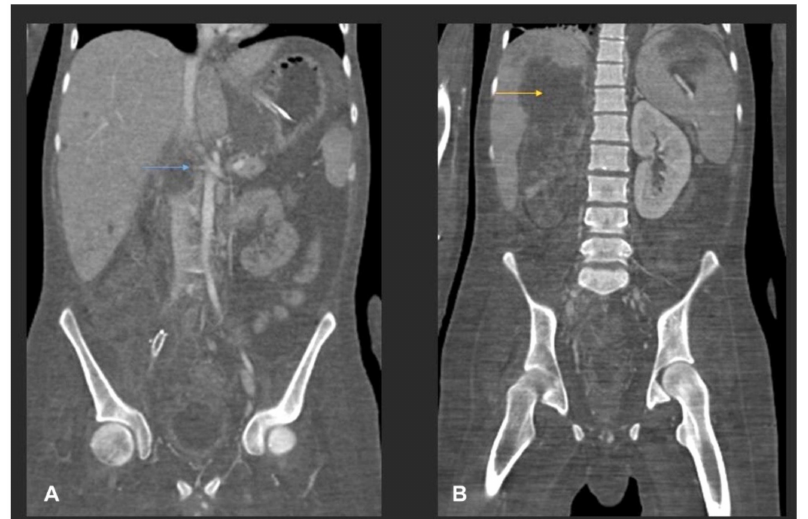
Figure 5. ( A ) MIP coronal images of abdomen shows a cut-off of the right proximal renal artery 1 cm from the ostium with adjacent inflammatory collection (blue arrow). ( B ) Coronal post-contrast CT shows infarction of the right kidney. A large liver abscess (yellow arrow) in the right liver lobe with extracapsular extension into the upper pole of the right kidney is also